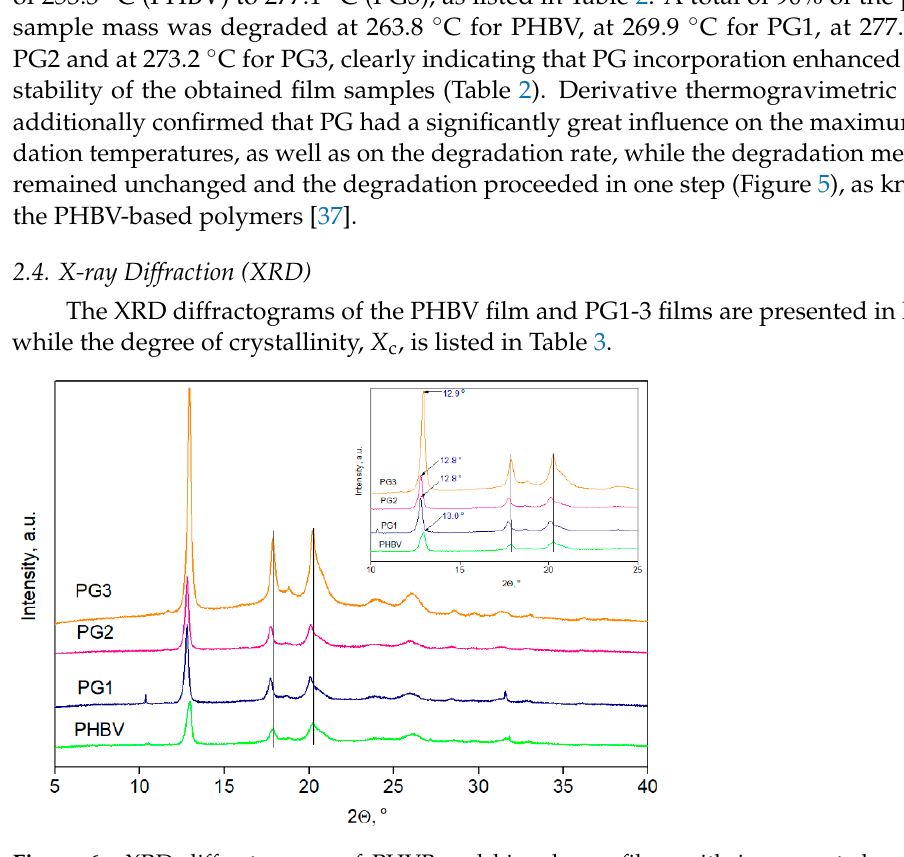
Figure 6. XRD diffractograms of PHVB and biopolymer films with incorporated prodigiosin (PG1–PG3). Table 3. XRD analysis results: degree of crystallinity, X c , full width at half-maximum (FWHM) of the peak, d -spacing and crystallite size, D